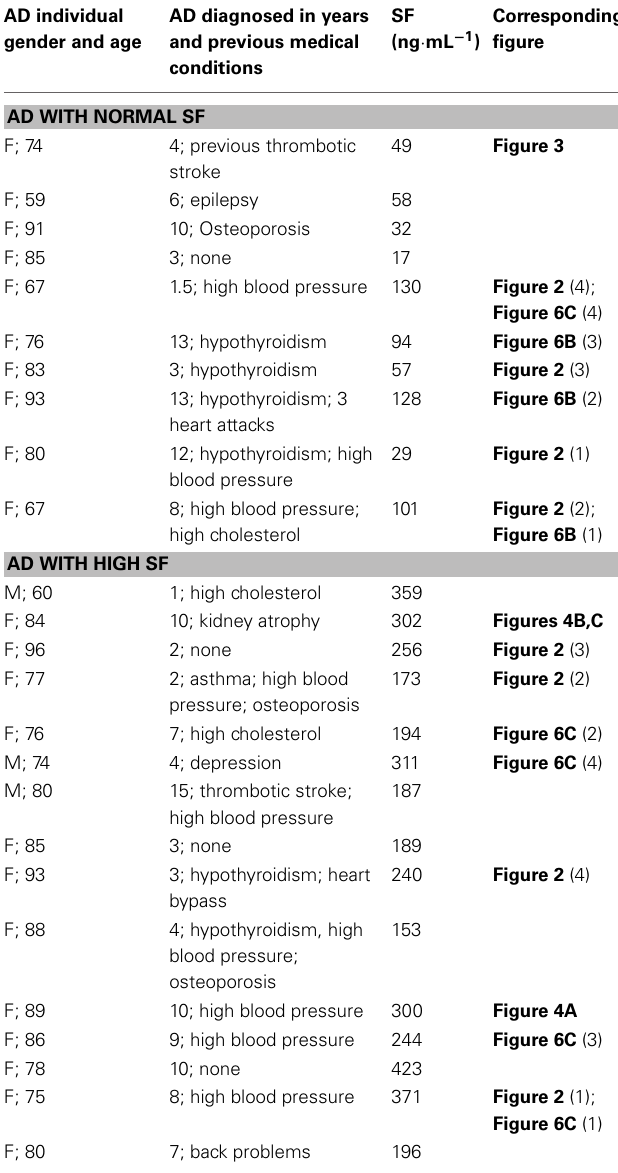
Table 1 | Serum ferritin levels (SF) of Alzheimer’s (AD) patients, history and corresponding figure